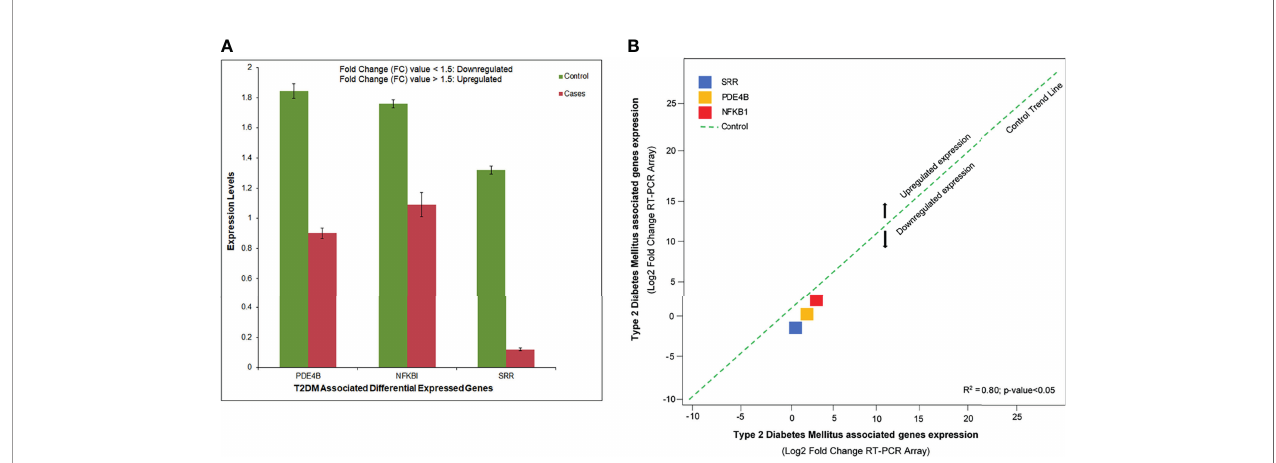
FIGURE 7 | (A) Abnormal expression levels of the differentially expressed genes (DEGs) in type 2 diabetes mellitus (T2DM) cases and controls based on the fold change of gene expression. (B) Quantitative real-time PCR (qRT-PCR) array validation of the DEGs. Plot graph shows the correlation between the expression levels